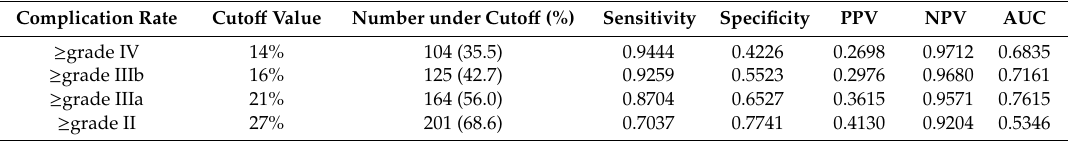
Table 4. Diagnostic characteristics of malignancy prediction according to the cuto ff and the severity of complications in the distal pancreatectomy group ( n = 293).